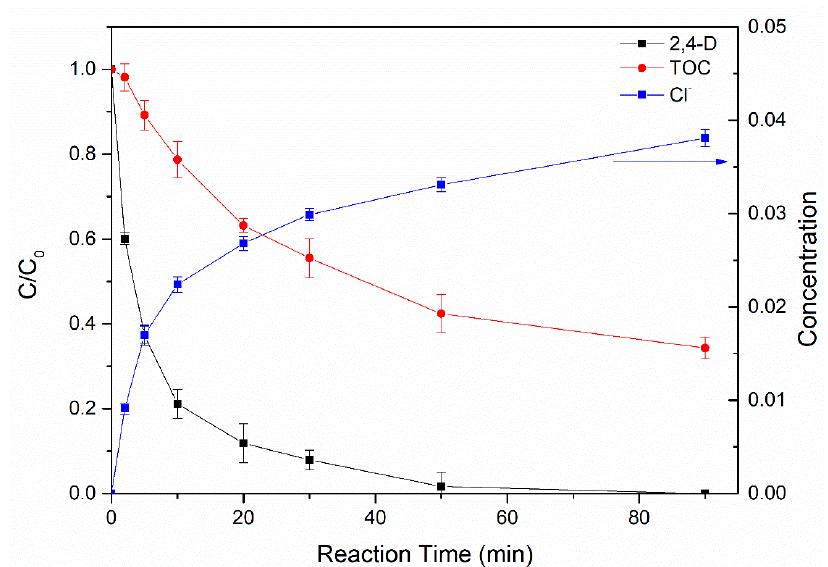
Figure 10. Changes of TOC and Cl - concentrations with the degradation of 2,4-D ([2,4-D] 0 = 5.0 mg/L, [Fe 0 @Fe 3 O 4 ] 0 = 0.5 g/L, H 2 O 2 = 1 mM, pH = 5.0 ± 0.2, T = 30 °C).